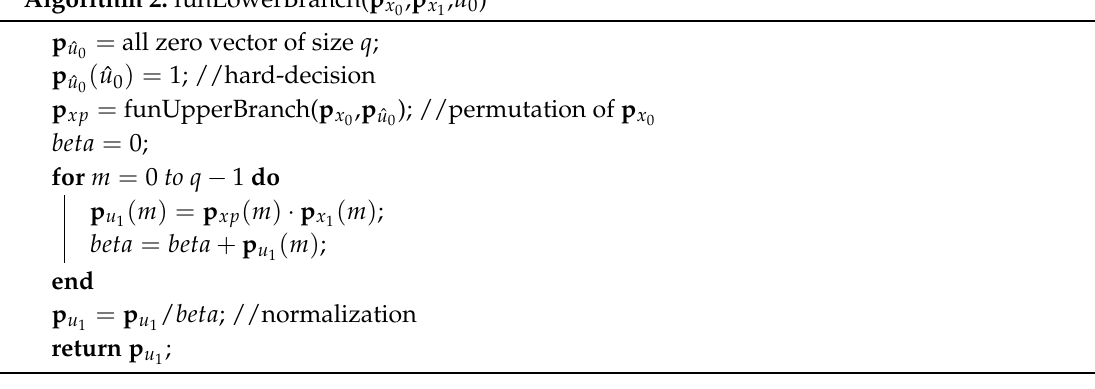
Algorithm 2: funLowerBranch( p x